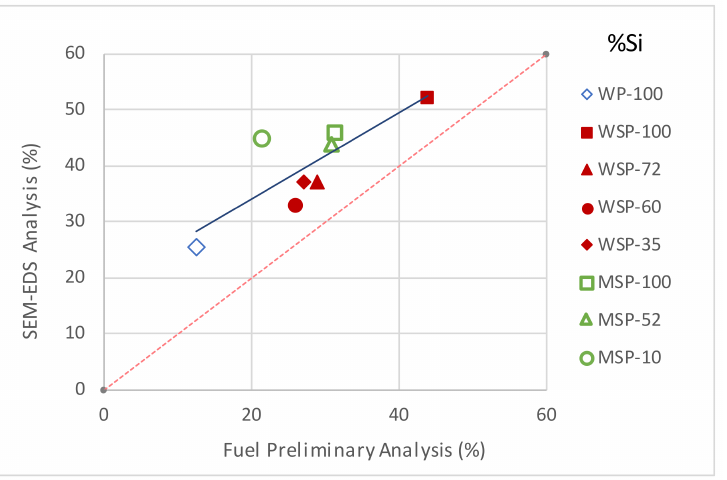
Figure 1. Si concentration in bottom ash versus Si concentration in fuel preliminary analysis.